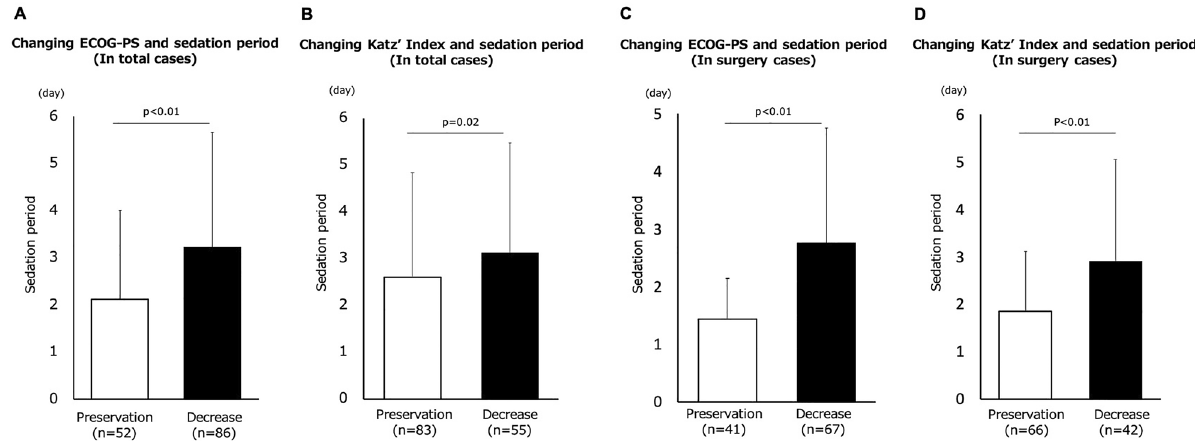
Figure 3. Comparison of the sedation period between two groups classified by changing score of ECOG-PS ( A , C ) and Katz index ( B , D ), respectively, in overall ( A , B ) and in surgery cases ( C , D